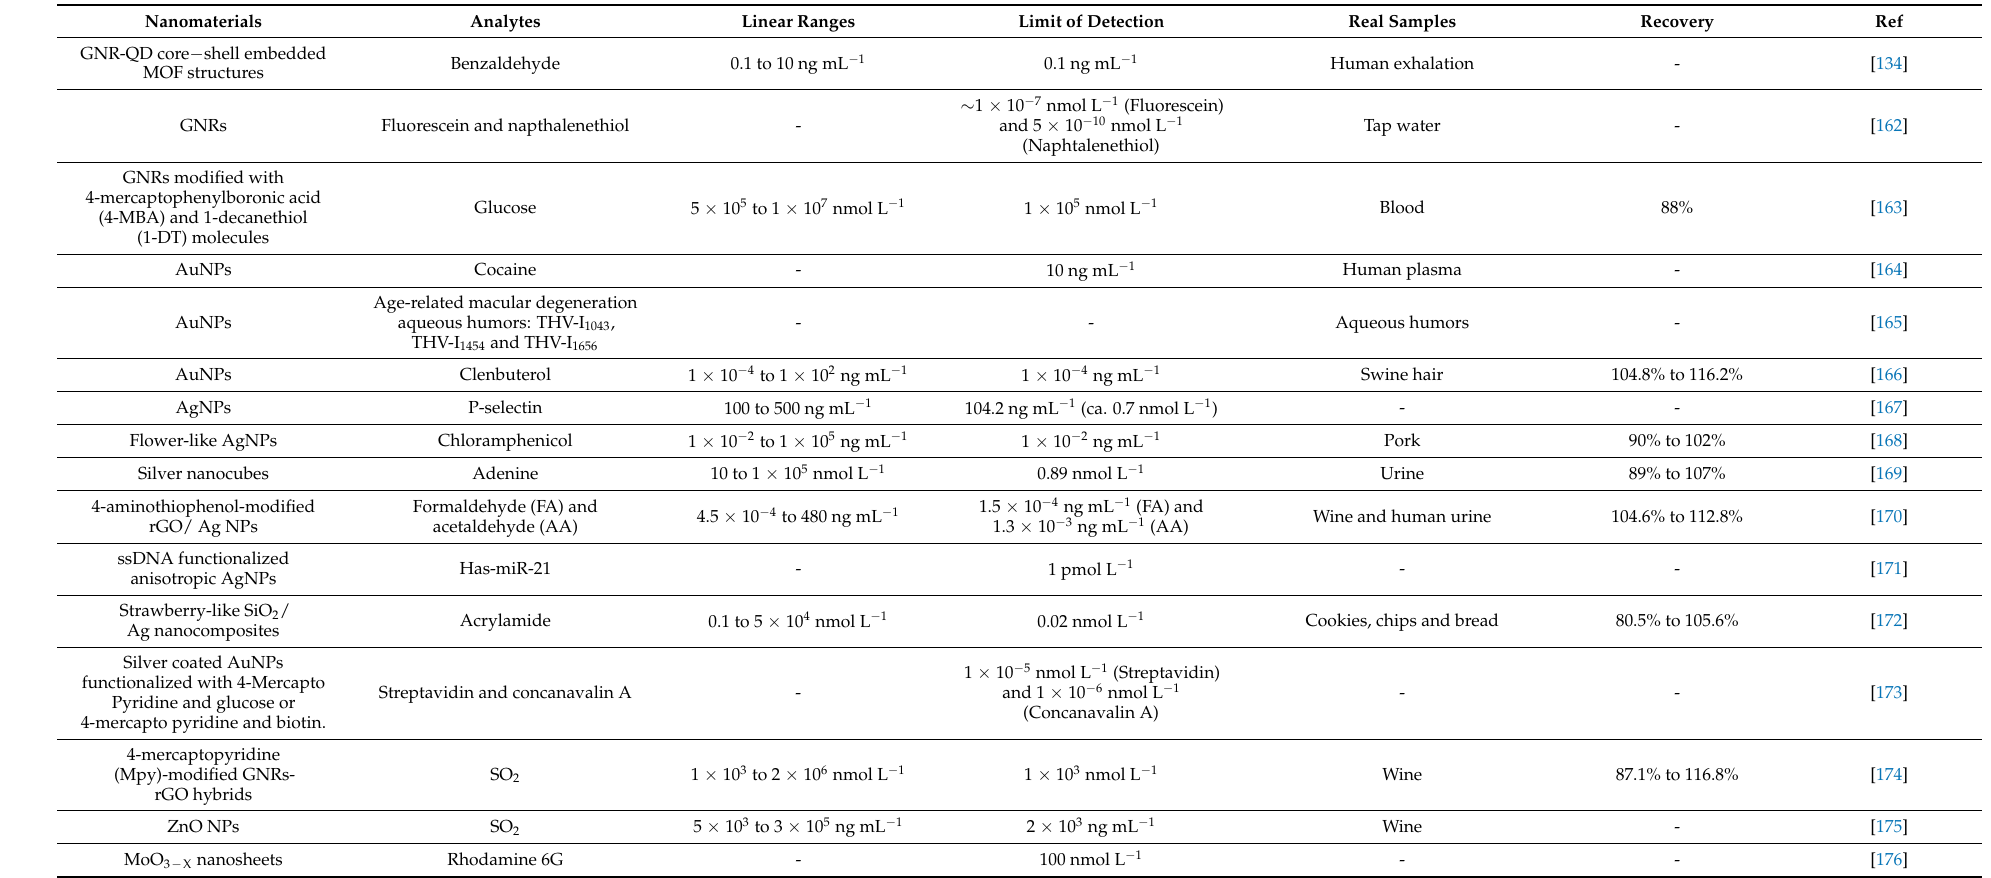
Table 4. The typical nanomaterial-based SERS PADs for sensing various